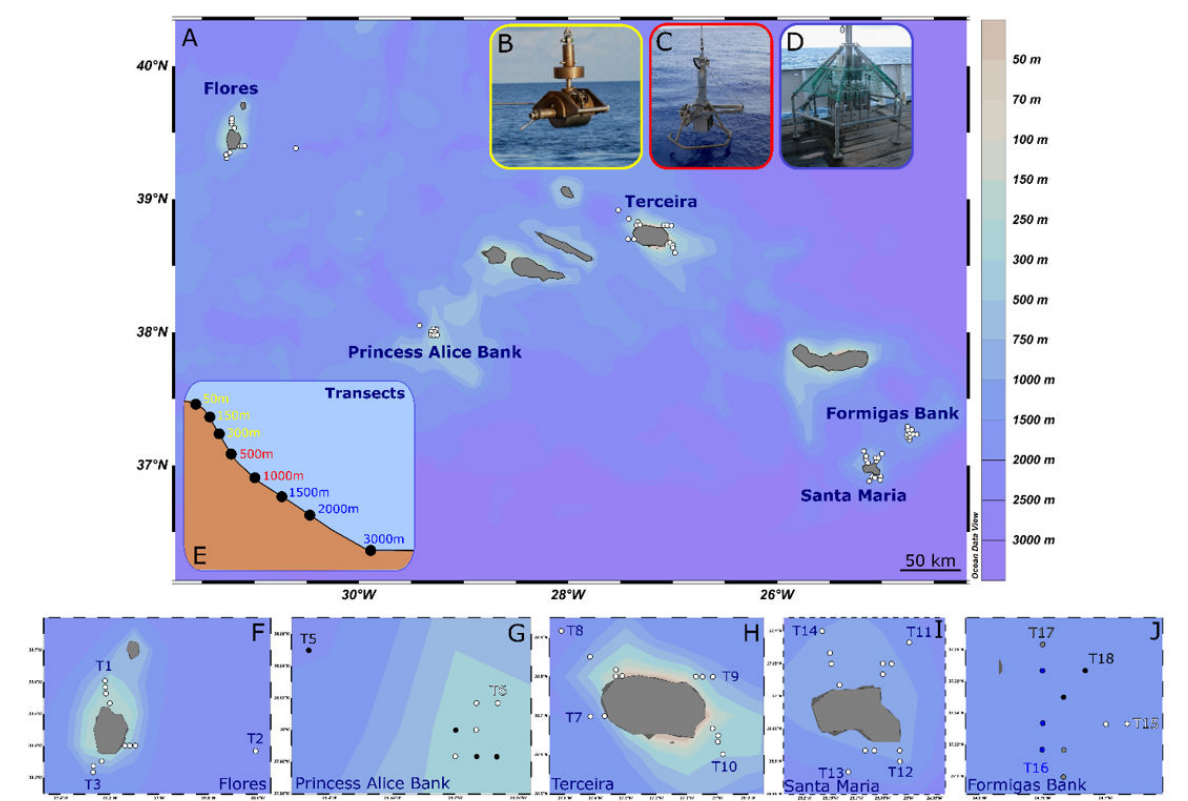
Figure 1. Sampling map showing ( A ) the sampled stations (indicated by white dots) around the Azores islands. Sediment was sampled using ( B ) a Shipek grab, ( C ) a Boxcorer, and ( D ) a Multicorer. Sampled depths are shown in ( E ). Colors indicate which sampling gear was used in each depth. Sampling sites of transect stations around ( F ) Flores, ( G ) Terceira, ( H ) Princess Alice Bank, ( I ) Santa Maria, and ( J ) Formigas Bank. Maps were created using Ocean Data View